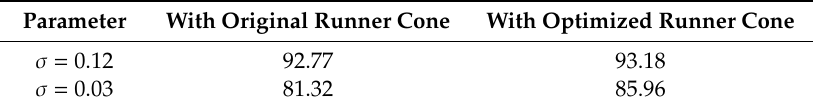
Table 5. Average e ffi ciency (%) at di ff erent Table 4. Average efficiency (%) at different conditions.